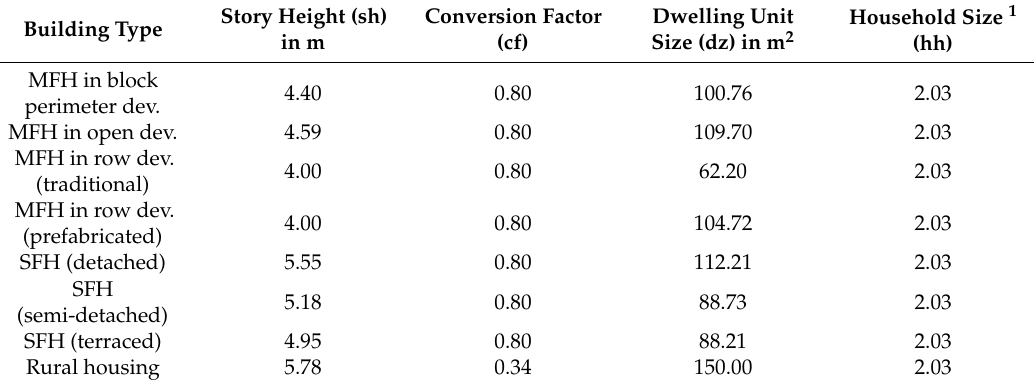
Table 1. Building-typical assumptions for the calculation of dwelling units and